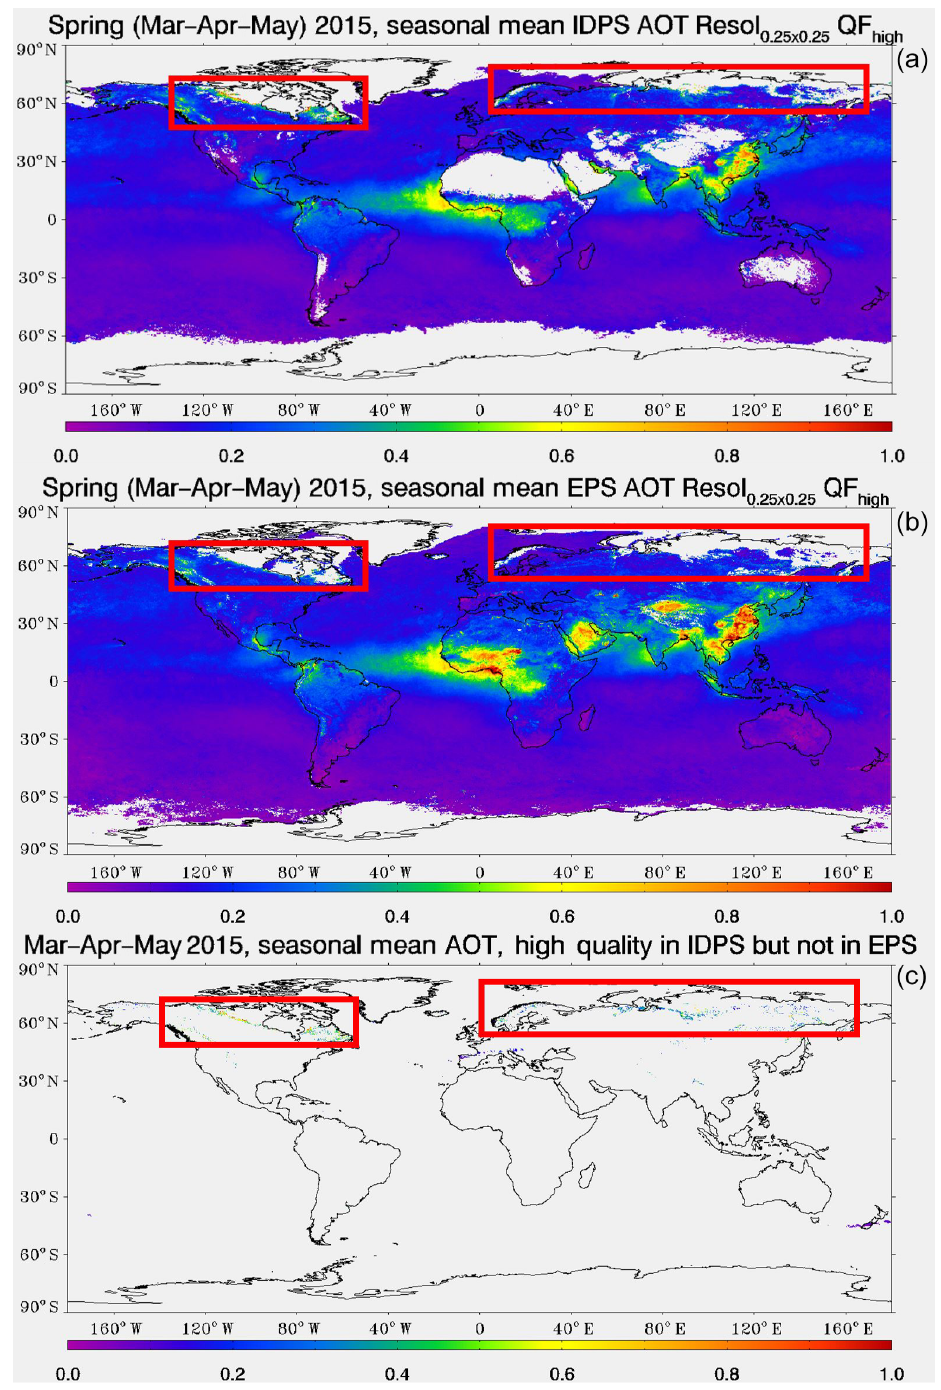
Figure 7. S-NPP VIIRS seasonal mean of good-quality AOD during the spring thaw season, March–May 2015: (a) with the old VRA-based snow test in the IDPS aerosol algorithm; (b) with the new snow and snowmelt screening scheme in the EPS aerosol algorithm; and (c) good- quality AOD retrievals in the IDPS product but not in the EPS product, mainly attributable to the improved snow and snowmelt tests. The most outstanding snow and snowmelt under-screening regions over Northern Hemisphere high-latitude regions are highlighted in red squares. In the maps shown, the original 750m pixel-level AOD retrievals were mapped to 0 . 25 × 0 . 25 ◦ equal-angle latitude–longitude